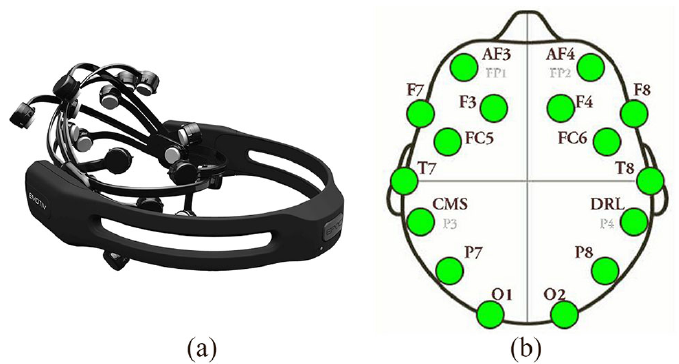
Figure 1. ( a ) Emotiv EPOC+ headset; ( b ) Spatial mapping of the electrodes on the scalp.